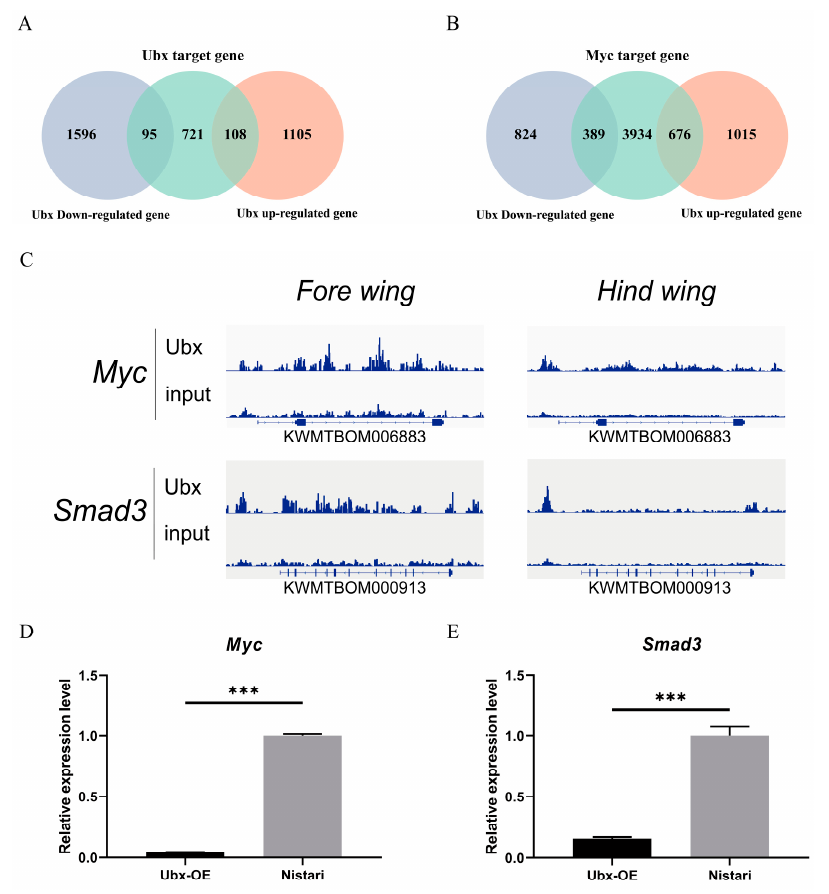
Figure 6. Target DEGs of Ubx and Myc. ( A ) Venn diagram of target genes of Ubx and DEGs. ( B ) Venn diagram of target genes of Myc and DEGs. ( C ) The binding peak map of Ubx in the Myc (ID: KWMTBOM006883) and Smad3 (ID: KWMTBOM000913) gene regions from ChIP-seq in the fore wing and hind wing of B. mori . ( D ) Expression of Myc in Ubx OE and Nistari. ( E ) Expression of Smad3 in Ubx OE and Nistari. Ubx-OE, the transgenic strain with Ultrabithorax overexpressed, namely Ubx OE . Nistari, the wild type of Ubx OE . Error bars indicate the standard error of the mean ( n = 3). Signi fi cant di ff erences were assessed using Student’s t -test (*** p < 0.001).